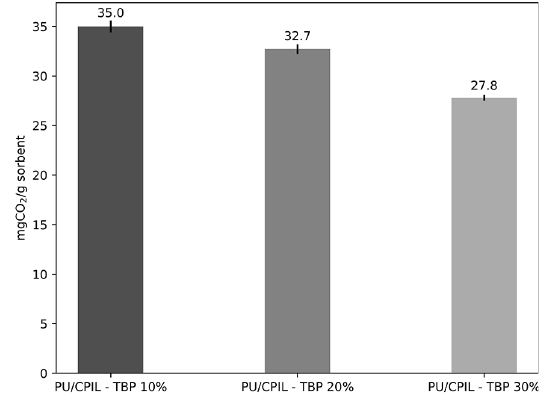
sorption capacity values 2